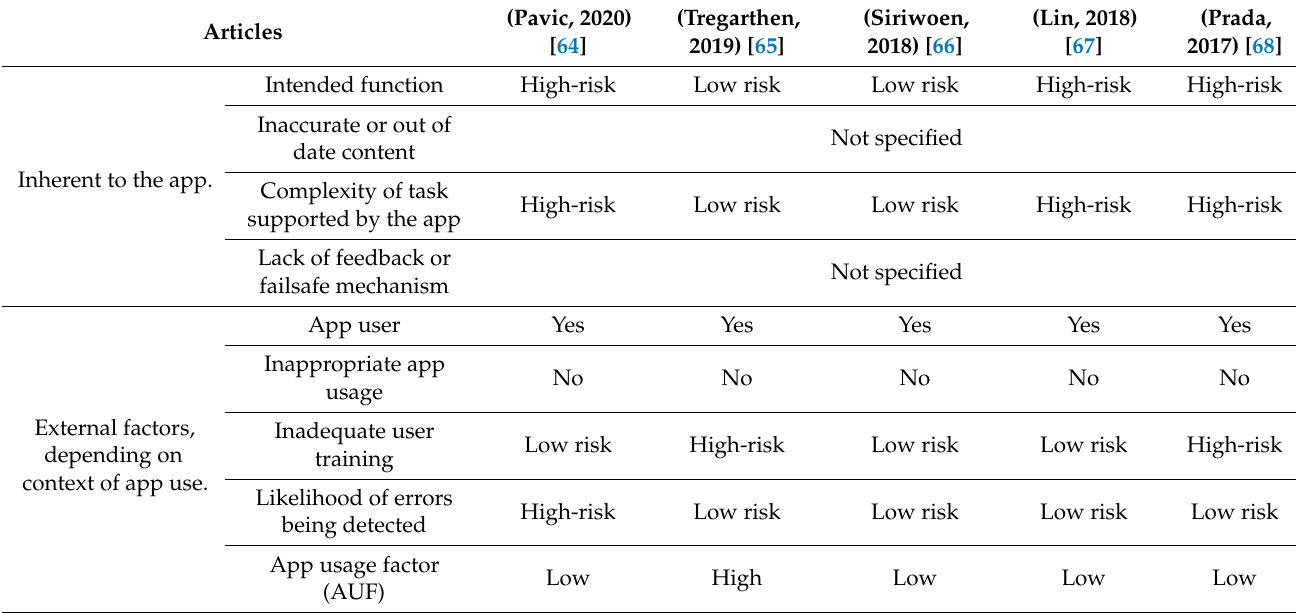
Table 3. Risk assessment of selected